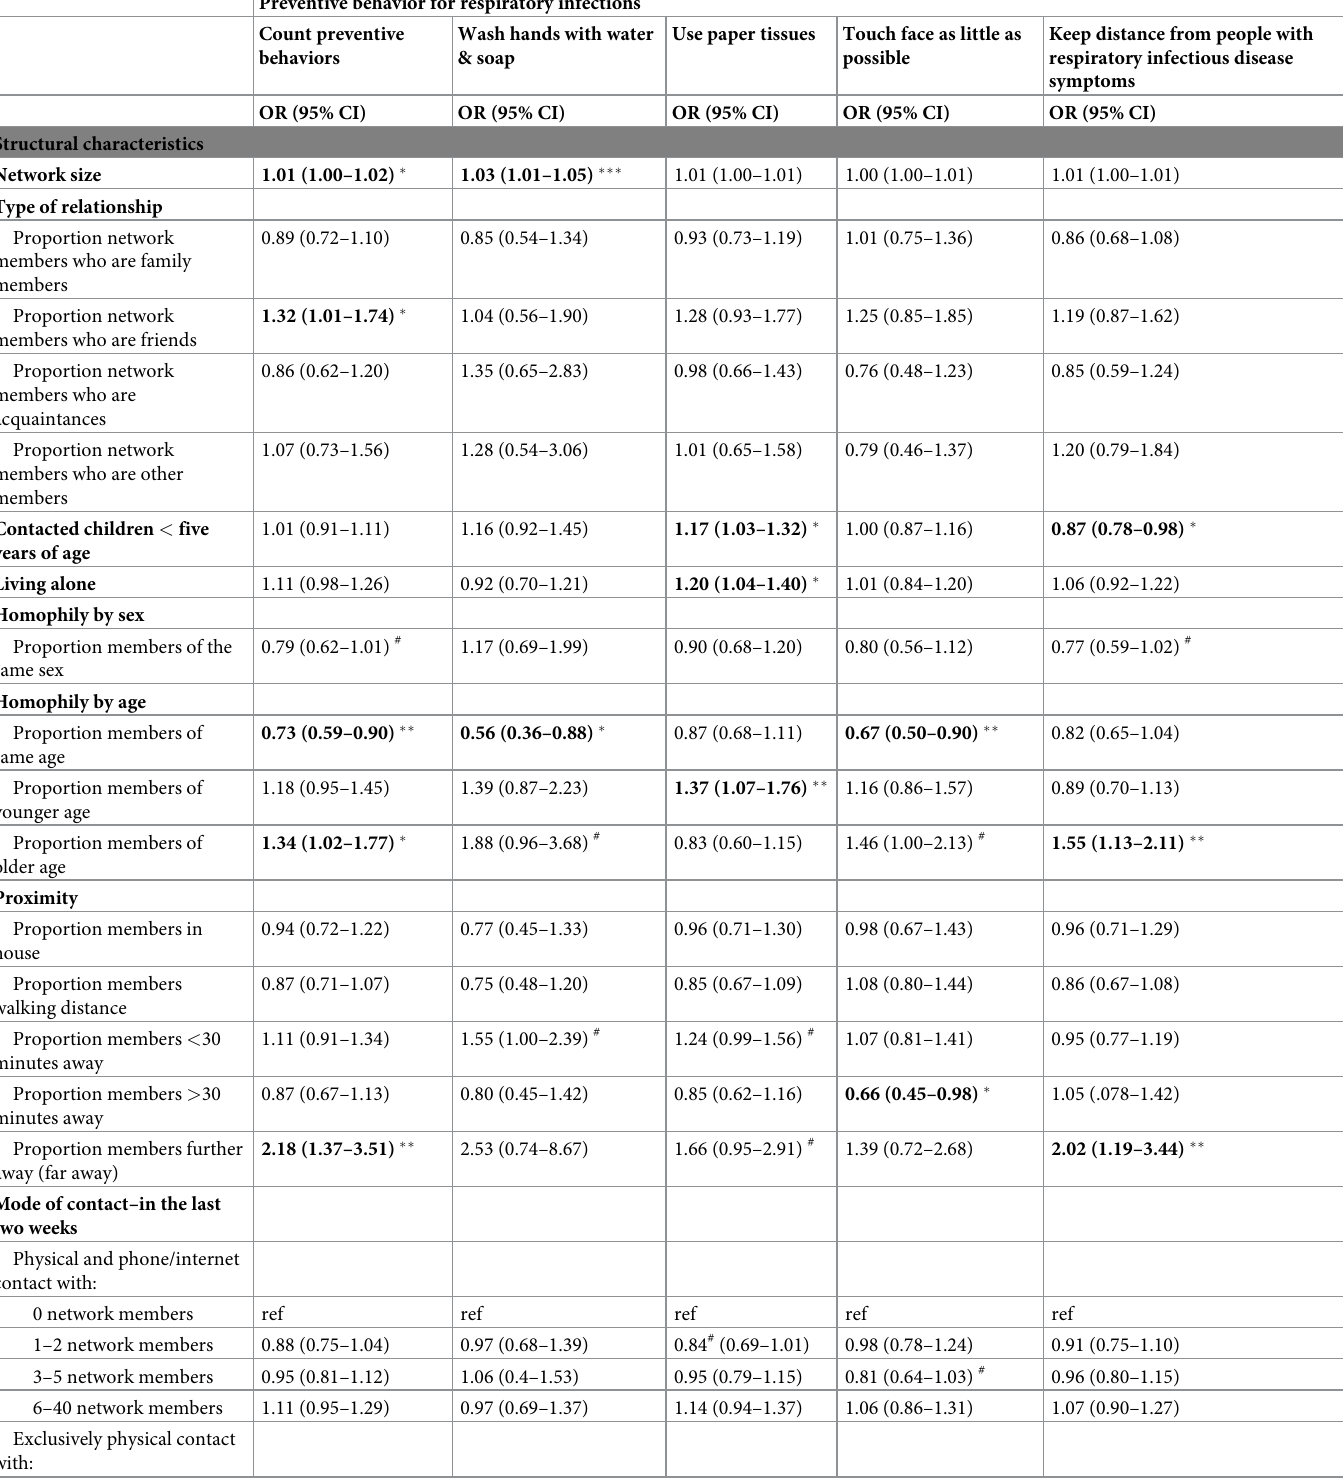
Table 3. Multivariate model I—associations between social network characteristics and preventive behaviors in SaNAE study